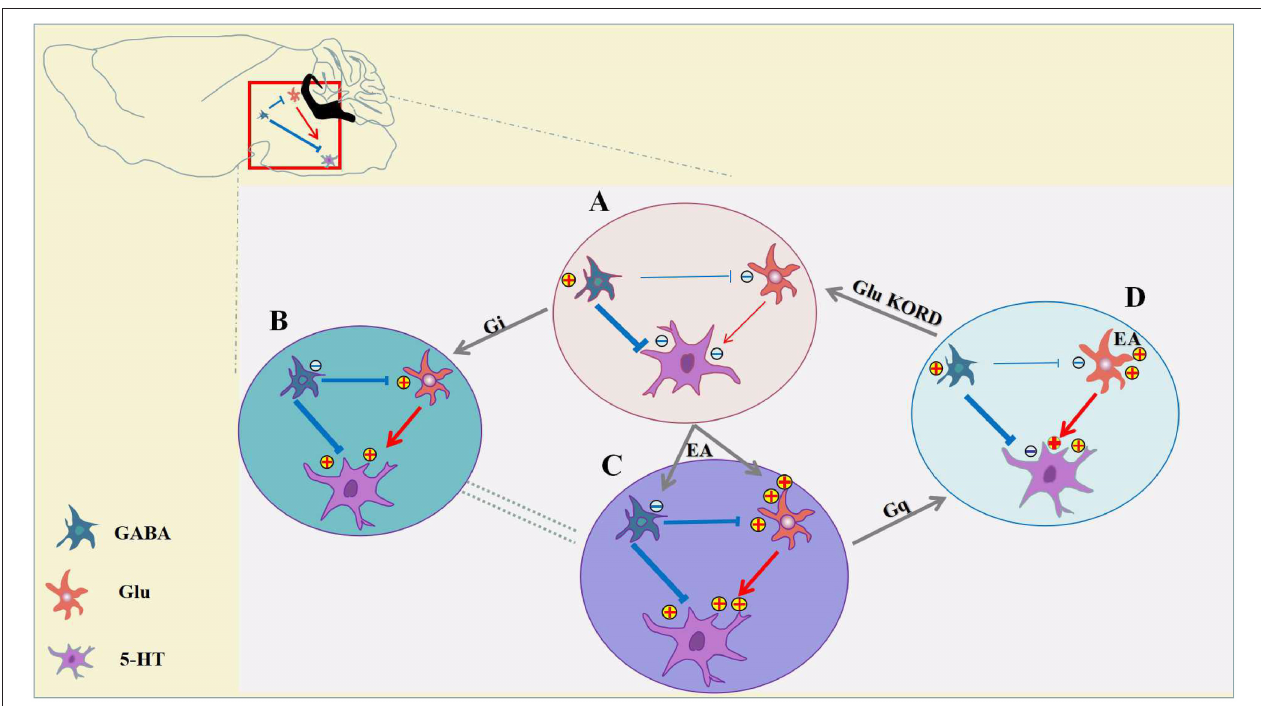
FIGURE 8 | Inhibition of GABAergic neurons and excitation of glutamatergic neurons in the vlPAG participate in EA analgesia. (A) Under pain conditions, GABAergic neurons are excited, resulting in glutamatergic, and serotoninergic neuron inhibition. (B) Chemogenetic inhibition of GABAergic neurons results in activation of glutamatergic neurons and serotoninergic neurons, and the descending inhibitory pain pathway would be activated to relieve the pain. (C) EA synchronously inhibits GABAergic neurons and activates glutamatergic neurons, thereby allowing serotoninergic neurons to be excited sufficiently. (D) With chemogenetic inhibition of GABAergic neurons, glutamatergic neurons are still activated by EA, and serotoninergic neurons in the descending inhibitory pain pathway remained partially activated. Chemogenetic activation of GABAergic neurons and inhibition of glutamatergic neurons is sufficient to attenuate the effects of